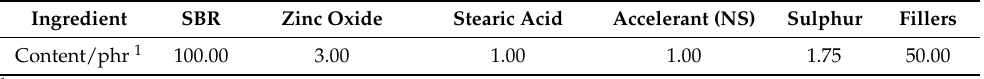
Table 2. Formulation of the coal gangue reinforced